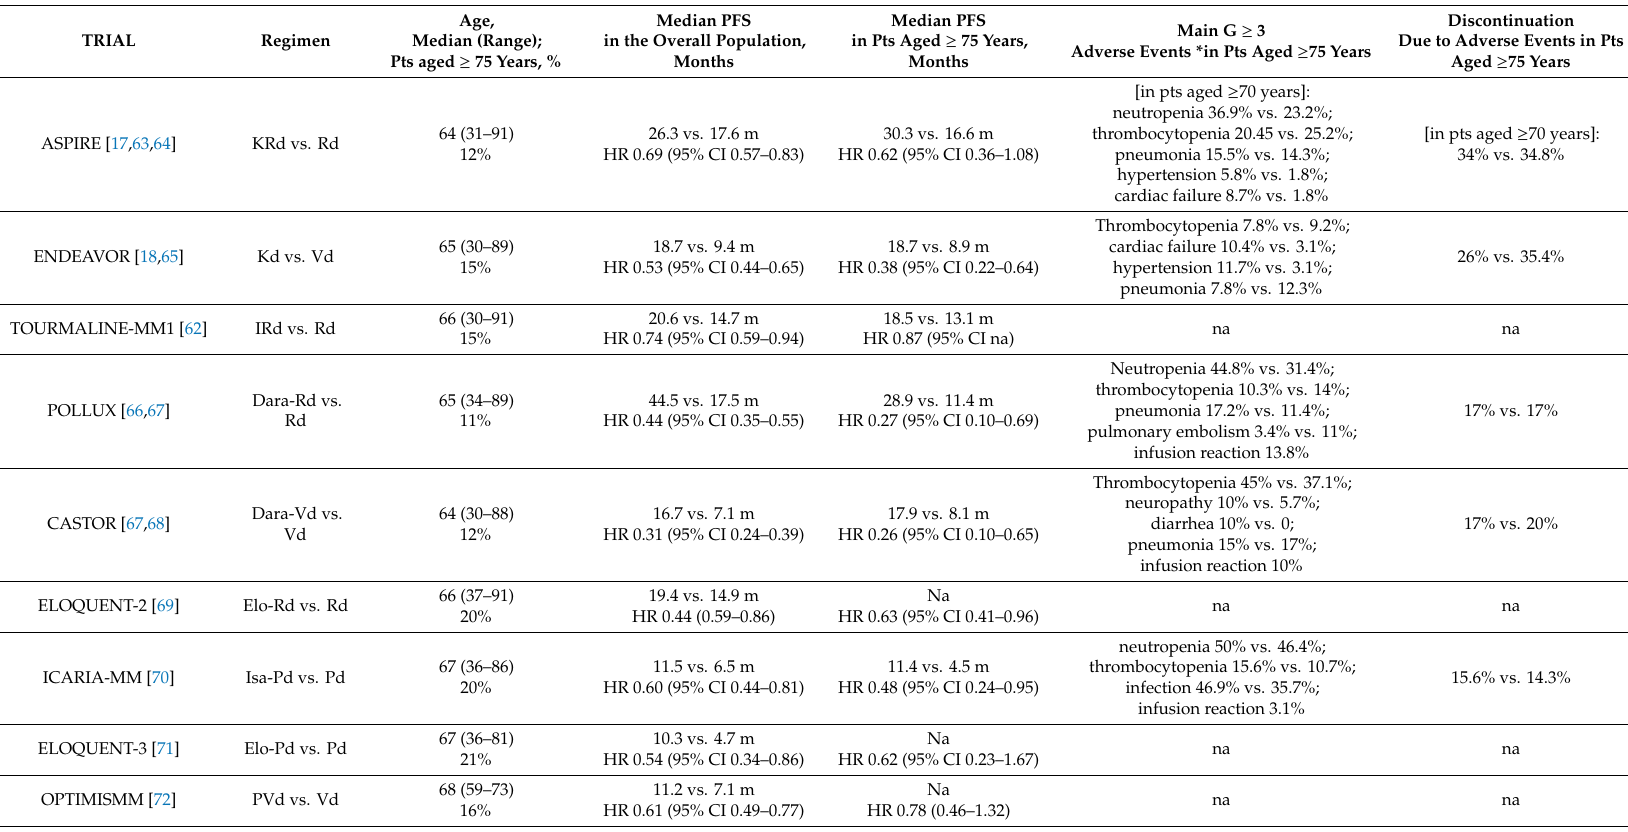
Table 2. Treatment outcome in ≥ 75-year-old patients enrolled in phase III clinical trials at